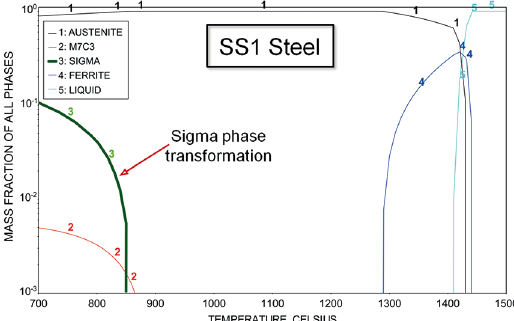
= 95 h; RA = 35%: (a) SEM and (b) OM. r